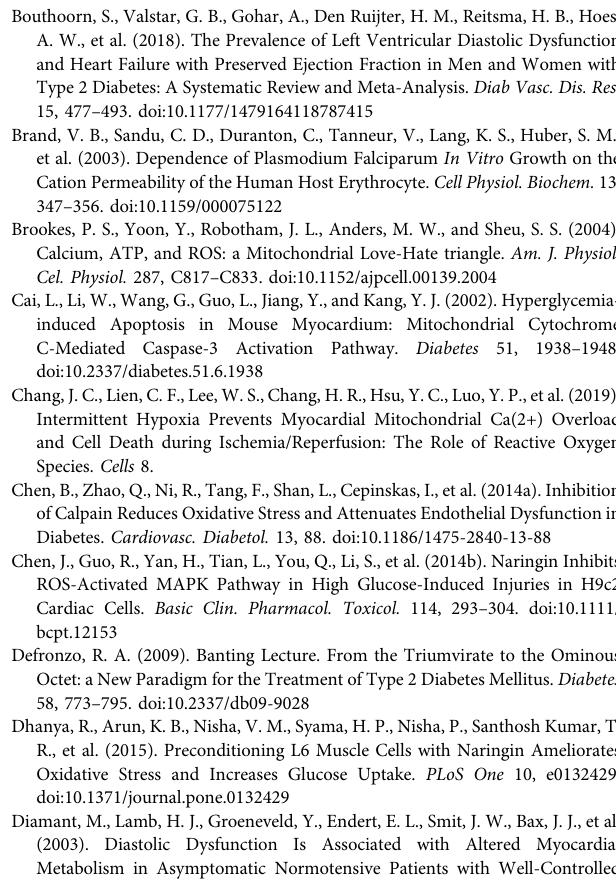
Supplemental Figure S2 | | Effects of naringin on [Ca 2+ ] d . Naringin reduced signi fi cantly [Ca 2+ ] d in T2D cardiomyocytes in a dose signi fi cant manner. Control and T2D cardiomyocytes were exposed to naringin (100, 200, or 300 µM) for 2 h, then measured [Ca 2+ ] d . Naringin provoked a dose- dependent reduction of [Ca 2+ ] d in cardiomyocytes isolated from T2D mice with no effect on control cardiomyocytes. n mice (cid:1) 3 controls and 4 T2D mice and n cells (cid:1) 16 – 20/group. Values are expressed as means ± S.D. Statistical analysis was performed as described before, ns p > 0.05, * p < 0.05, ***